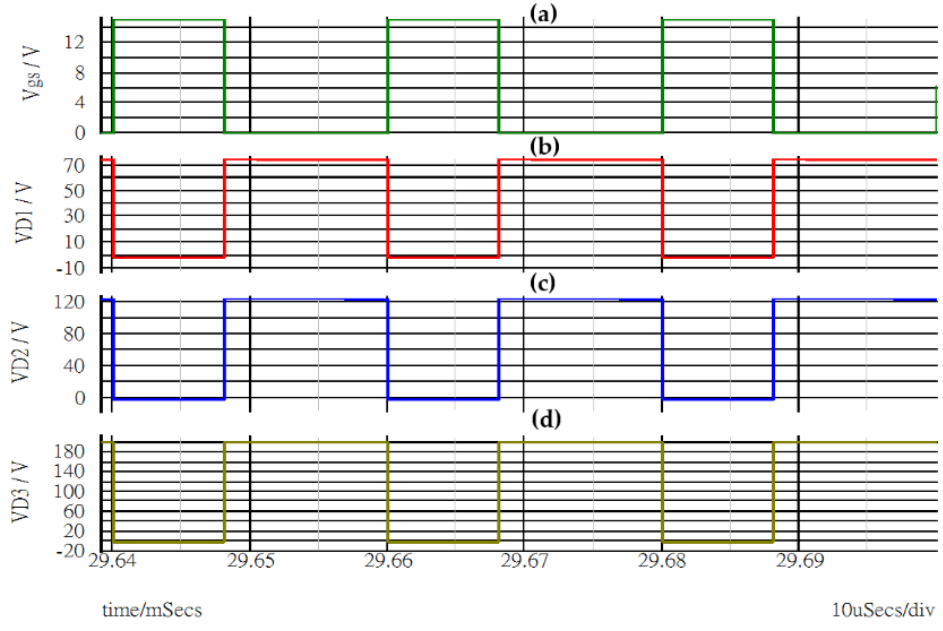
Figure 14. Simulated waveform of ( a ) duty cycle (V gs ) at duty d = 0.402, ( b ) Voltage stress of diode D 1 (V D1 ), ( c ) Voltage stress of diode D 2 (V D2 ), and ( d ) Voltage stress of diode D 3 (V D3 ).